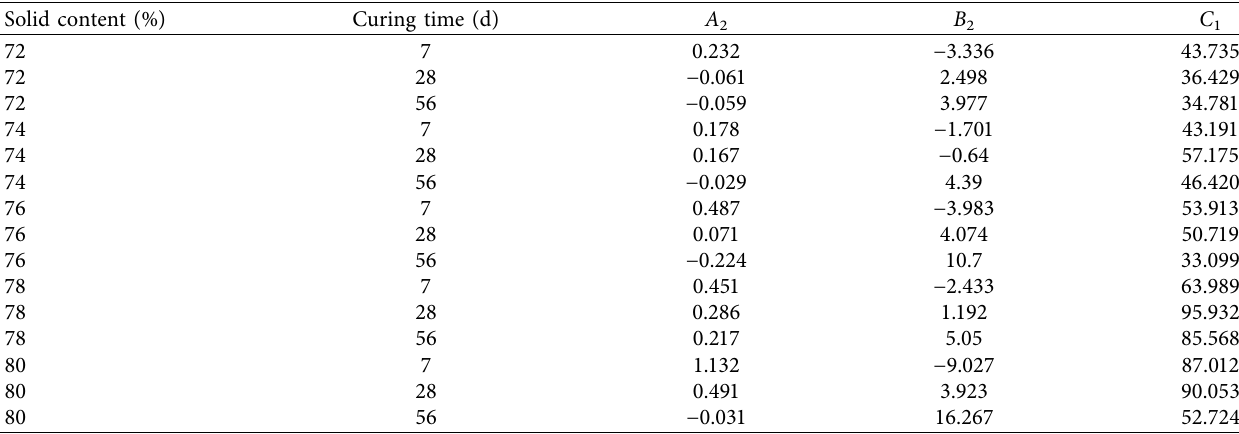
Table 17: Equation parameters results under various c/t